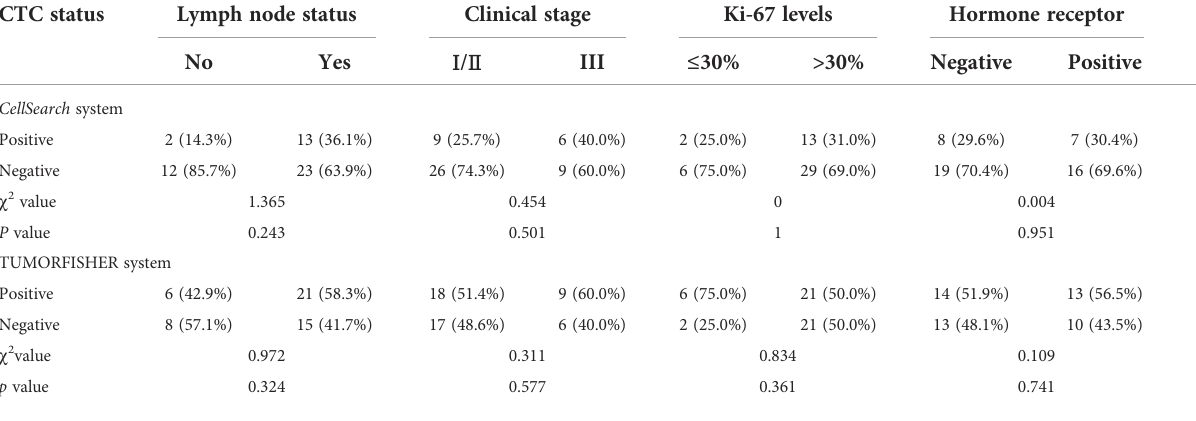
TABLE 3 Relationship between CTC levels and clinicopathological characteristics in 50